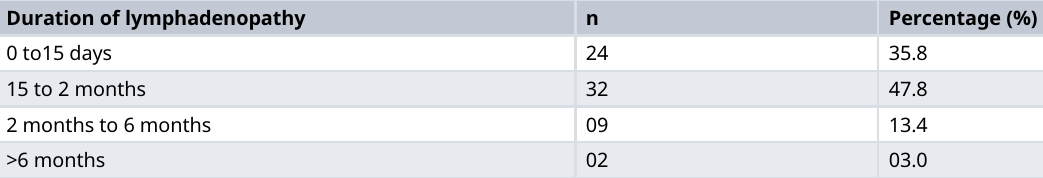
Table 4. Duration of lymphadenopathy of KFD patients